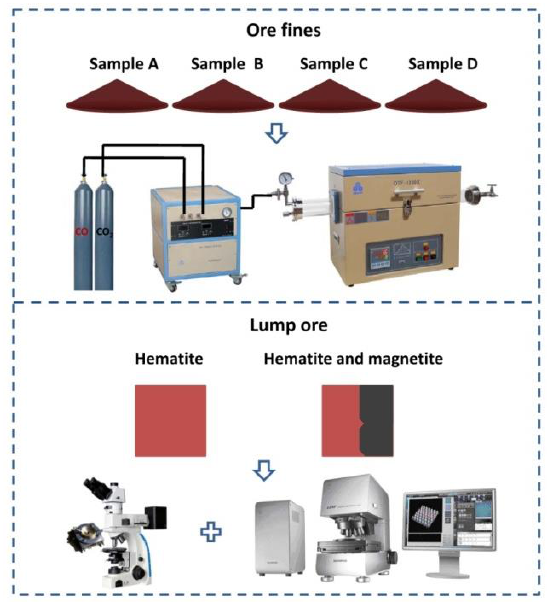
Figure 3. The experimental process of ore fines and lump ores.